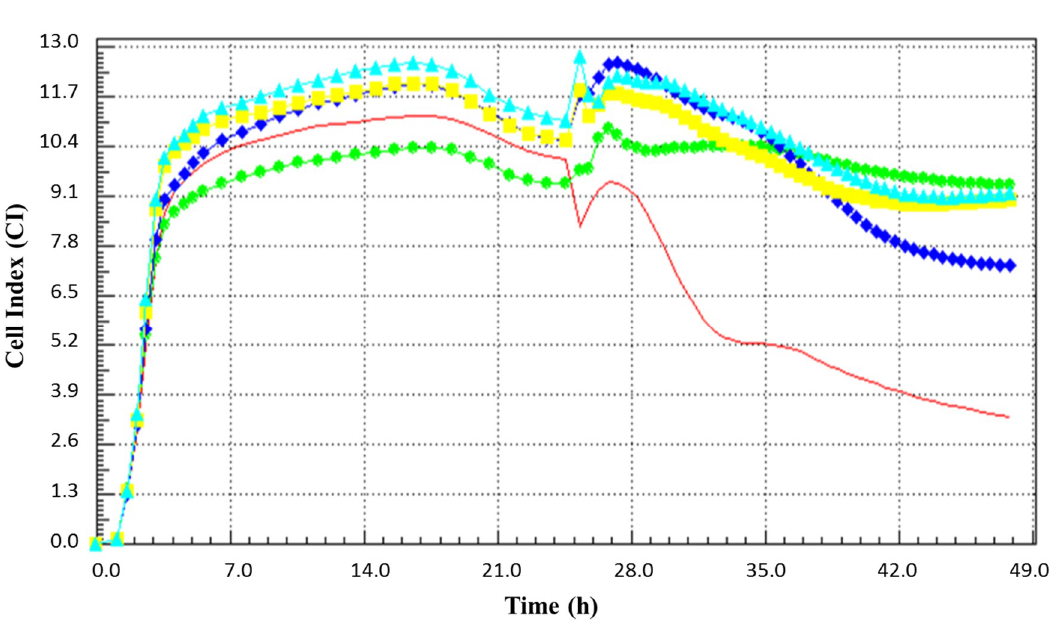
Figure 3. The real time cell monitoring profile of MA104 cells treated with 0.25 mg / mL of BCE prior to the rotavirus infection. The blue diamond line is the BCE, the light blue triangle line is the autoclaved BCE, the yellow square line is the heat treated BCE, the red line represents infected cells, and green circle line represents non-infected cells. Table 2. The antiviral e ff ects of enzyme treatment of BCE prior to infection of MA104 cells. Enzyme Treatment The Number of Infected Wells (per 8